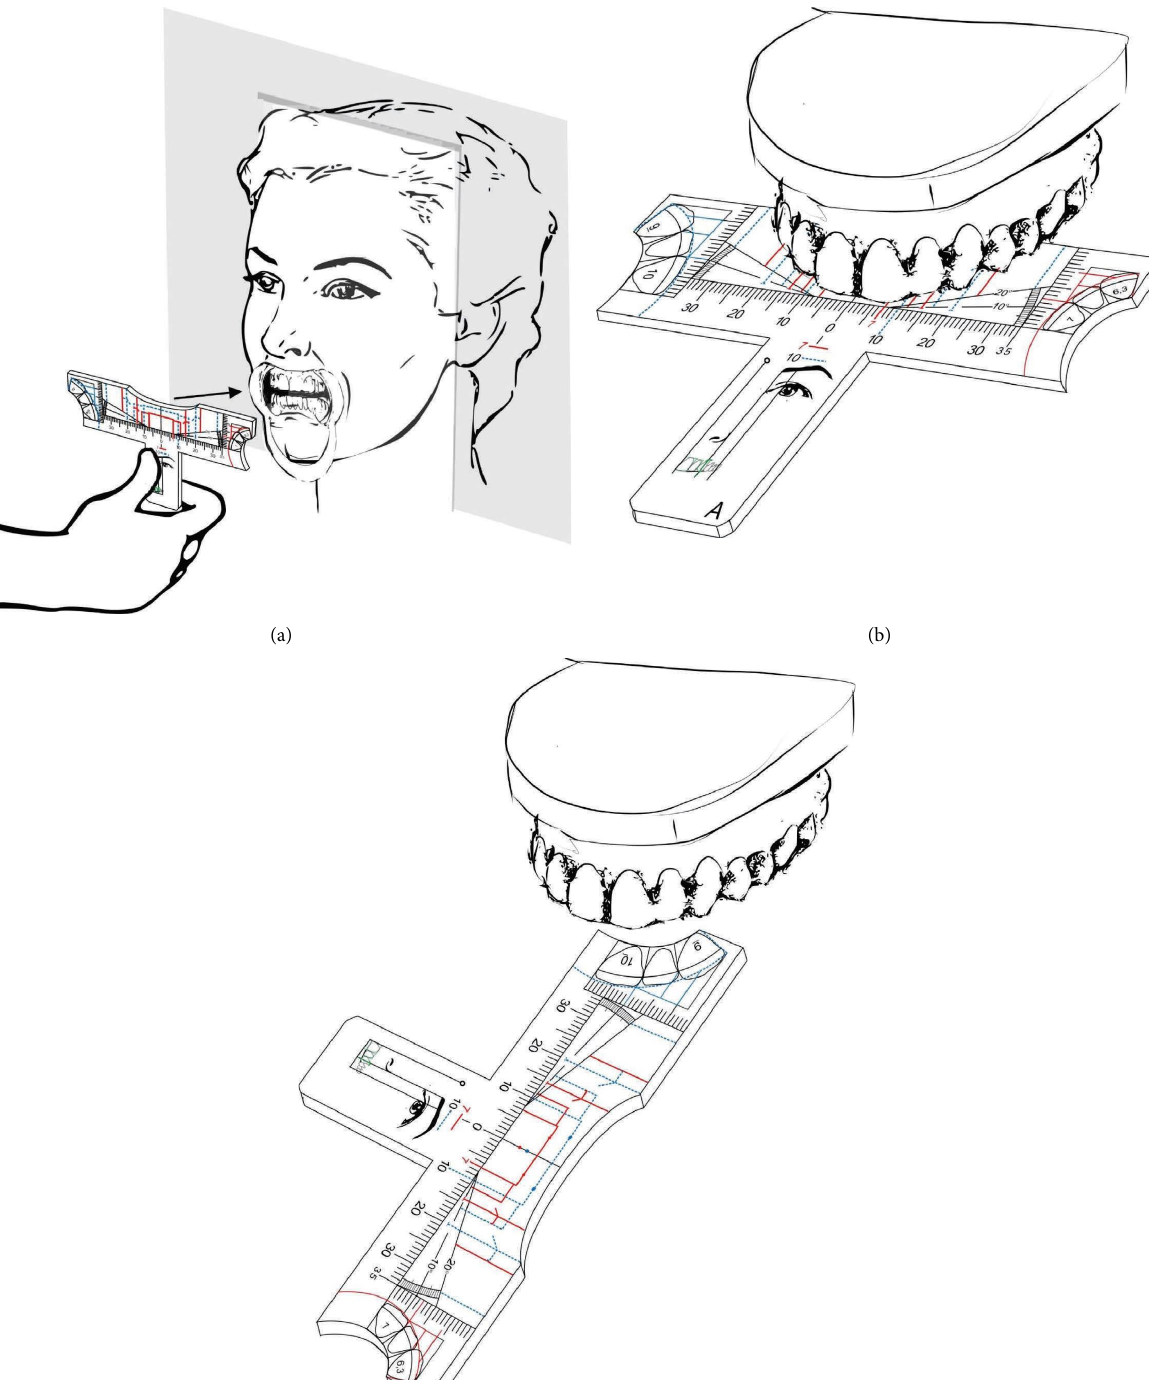
Figure 10: In (a)–tooth analysis invention handling illustration, being the template parallel to the coronal plane, and ideally using oral retractors for better visualization. In (b)-the invention handling illustration over a desk when using plaster dental casts or in (c)–using the ideal individual proportion drawings on the lateral of the